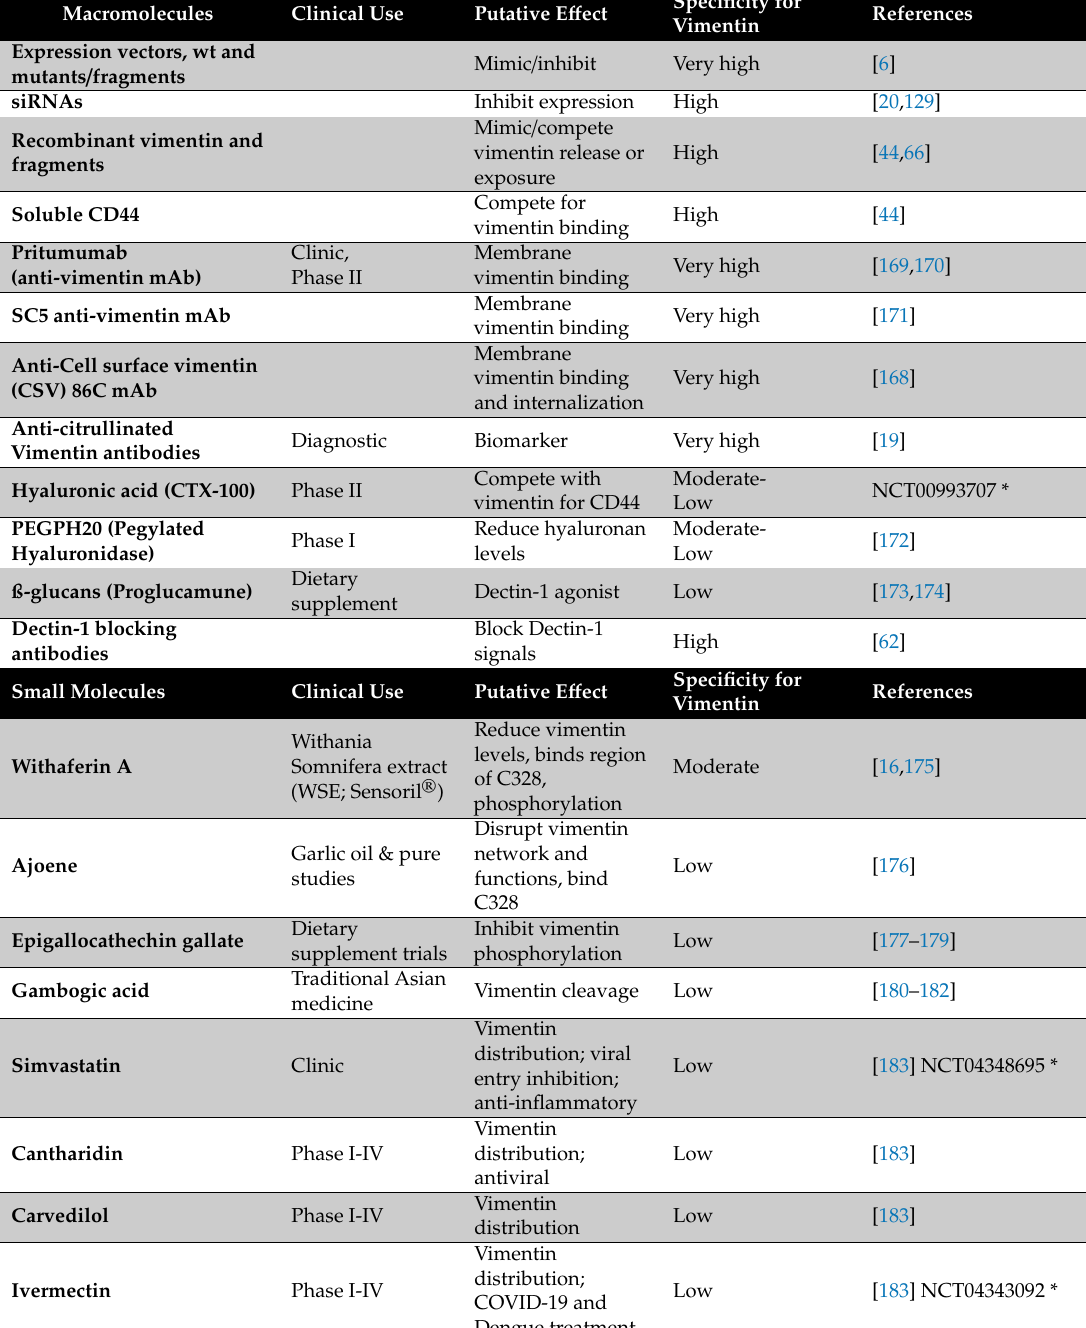
Table 1. Agents / Strategies a ff ecting vimentin